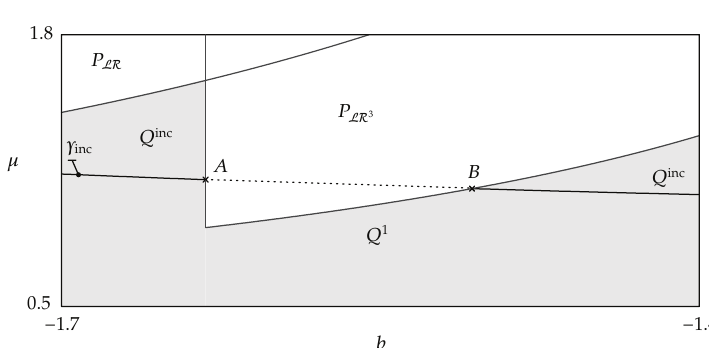
Figure 7: Analytically determined structure of the (cid:7) b,μ (cid:8) -plane for a (cid:6) 0 . 23, b (cid:6) − 1 . 7 ··· − 1 . 4, μ (cid:6) 0 . 5 ··· 1 . 8. The band-merging crisis curve γ inc intersects the periodic region P s LR marked with A and B , Q 1 is adjacent to the periodic region. For values of b smaller than A or larger than B , Q 1 is adjacent to Q inc